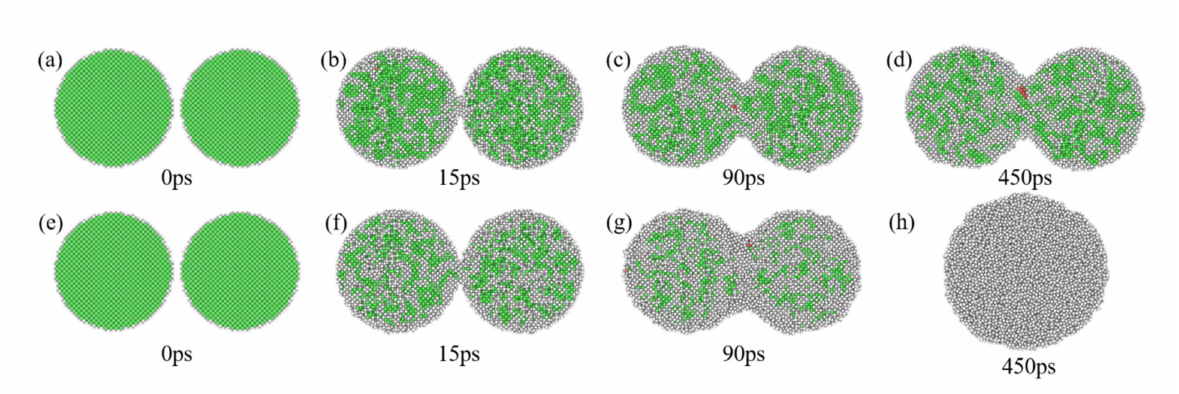
Figure 8. The structural evolution of EPs-8 during the sintering process corresponding to the sintering time. ( a – d ) Premelting sintering process (sintering temperature is 1000 K) and ( e – h ) liquid-phase sintering process (sintering temperature is 1100 K). The color bar is the same as that in Figure 5.